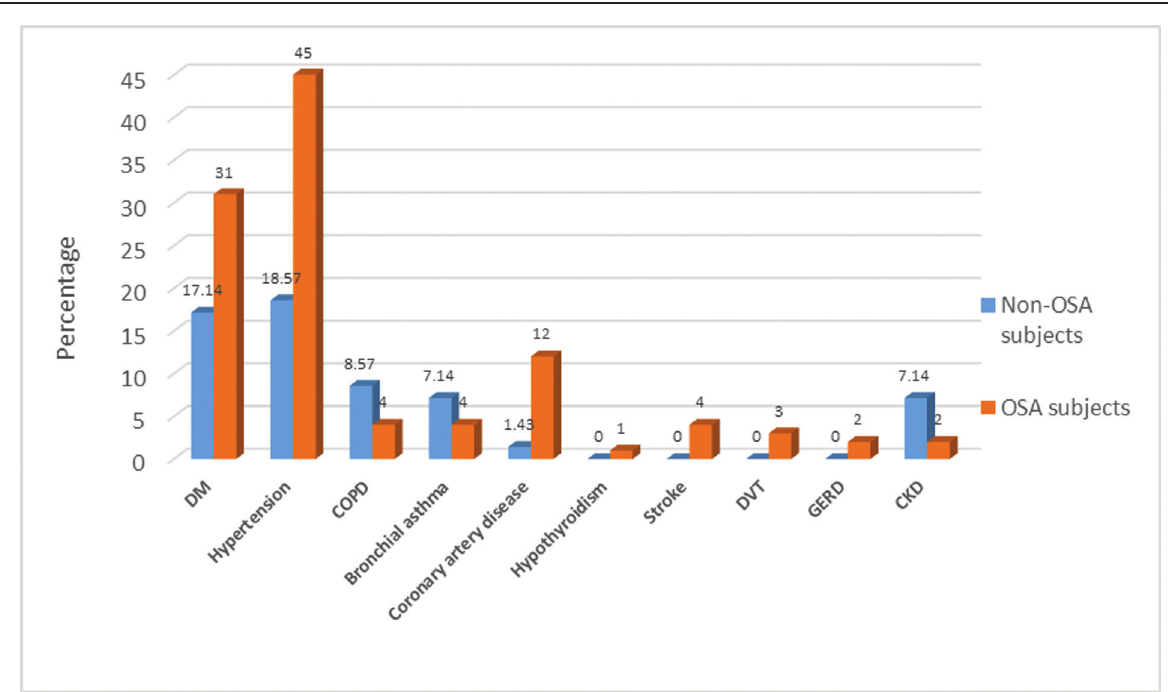
Comorbidities in the studied